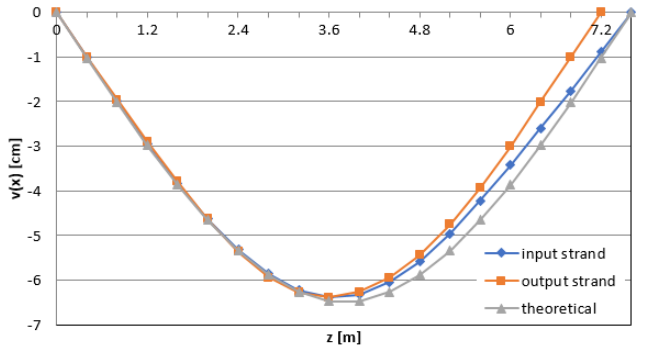
Figure 11. Centerline deformation imposed at 6.5 cm.